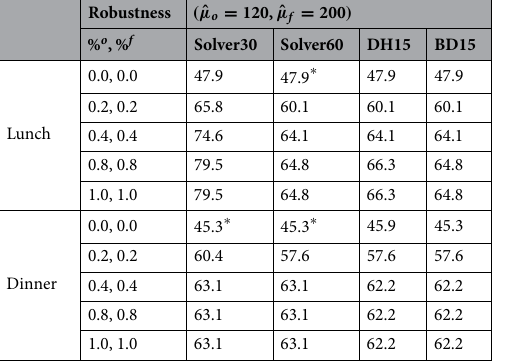
Table 7. Objective value of RO model through different approaches. ∗ means that the problem is optimally solved within the specified time limit.